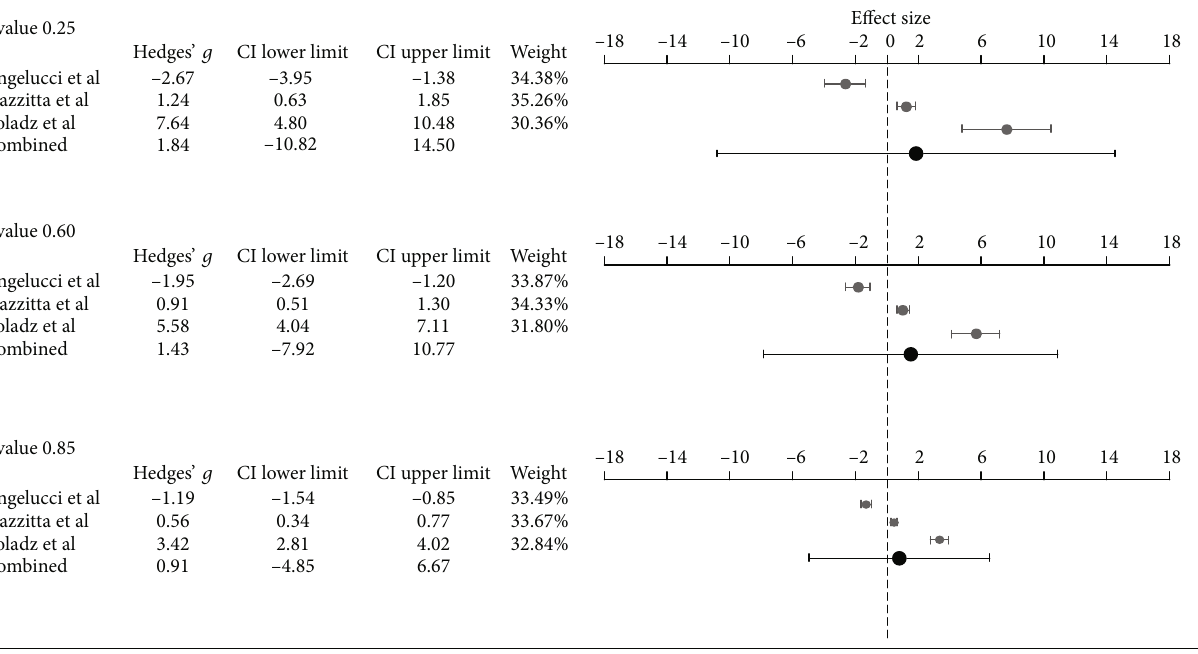
Figure 2: Meta-analyses and forest plots of included studies using three di ff erent r values, showing e ff ect sizes (Hedges ’ g ) of change in levels of brain-derived neurotrophic factor from pre- to